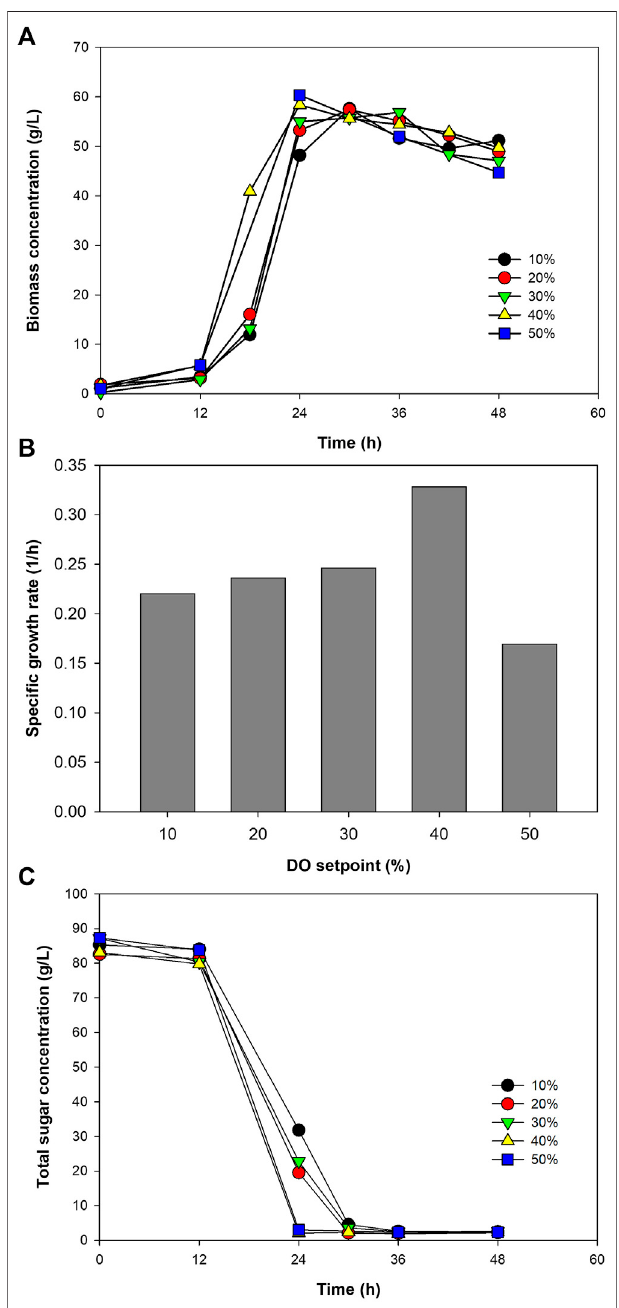
FIGURE 3 | Growth pro fi les of Paracoccus sp. KKU01 on sugarcane juice-based media (A) , speci fi c growth rate of the bacterium (B) , and total sugar consumption (C) at DO setpoints ranging from 10 to